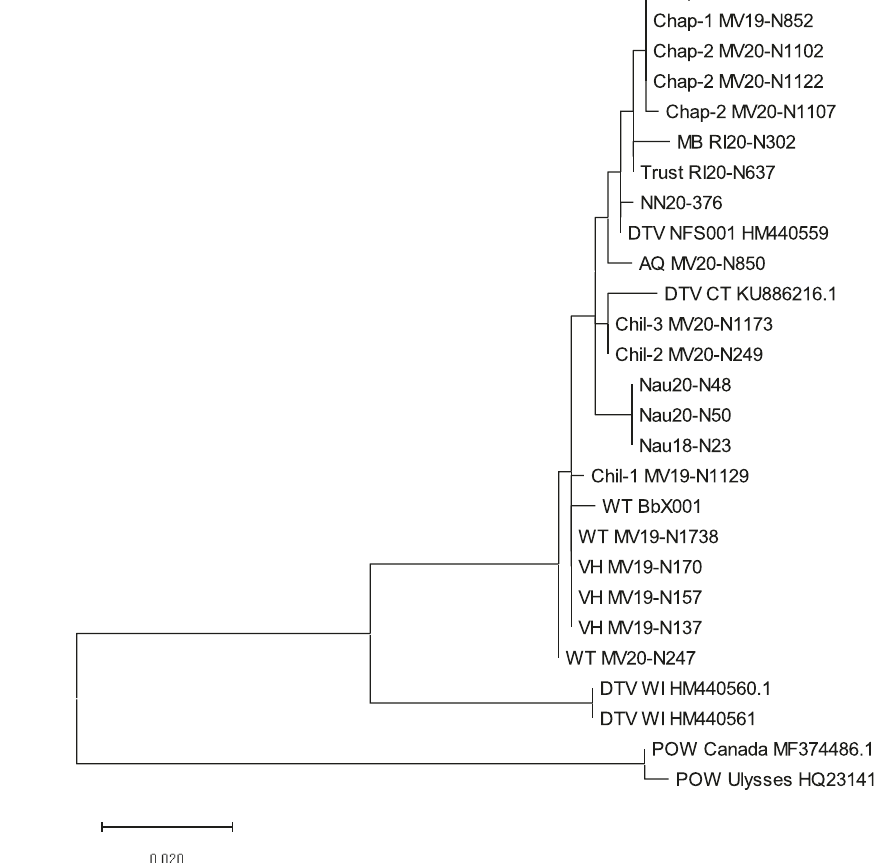
Fig. 2 Maximum likelihood tree of deer tick virus (DTV) detected in this study. A 248 bp piece of the NS5 gene and the 286 bp piece of the envelope gene were sequenced from each positive tick in the study, as well as the positive shrew. These pieces were concatenated and aligned with deer tick virus (DTV) and Powassan virus (POW) sequences downloaded from GenBank (GenBank numbers are listed on the tree). A maximum likelihood tree was then created using